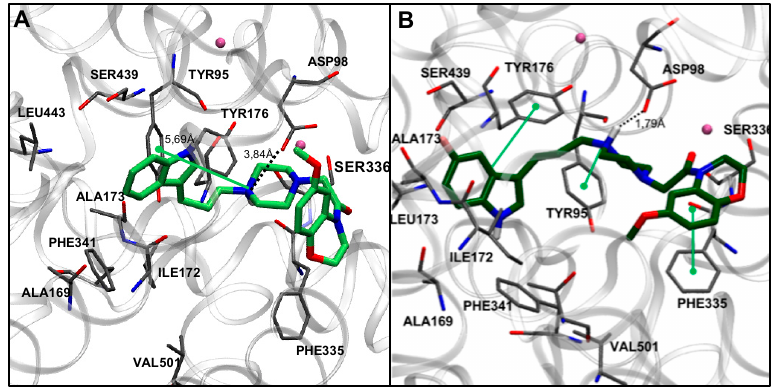
Figure 2. Comparison of the docking poses in SERT obtained for compounds 7f ( A ) in light green and 7l ( B ) in dark green. Nearby residues <5Å (grey sticks) and Na + atoms (pink spheres) are shown. Dotted lines represent ionic interactions and aromatic interactions are shown with green lines.